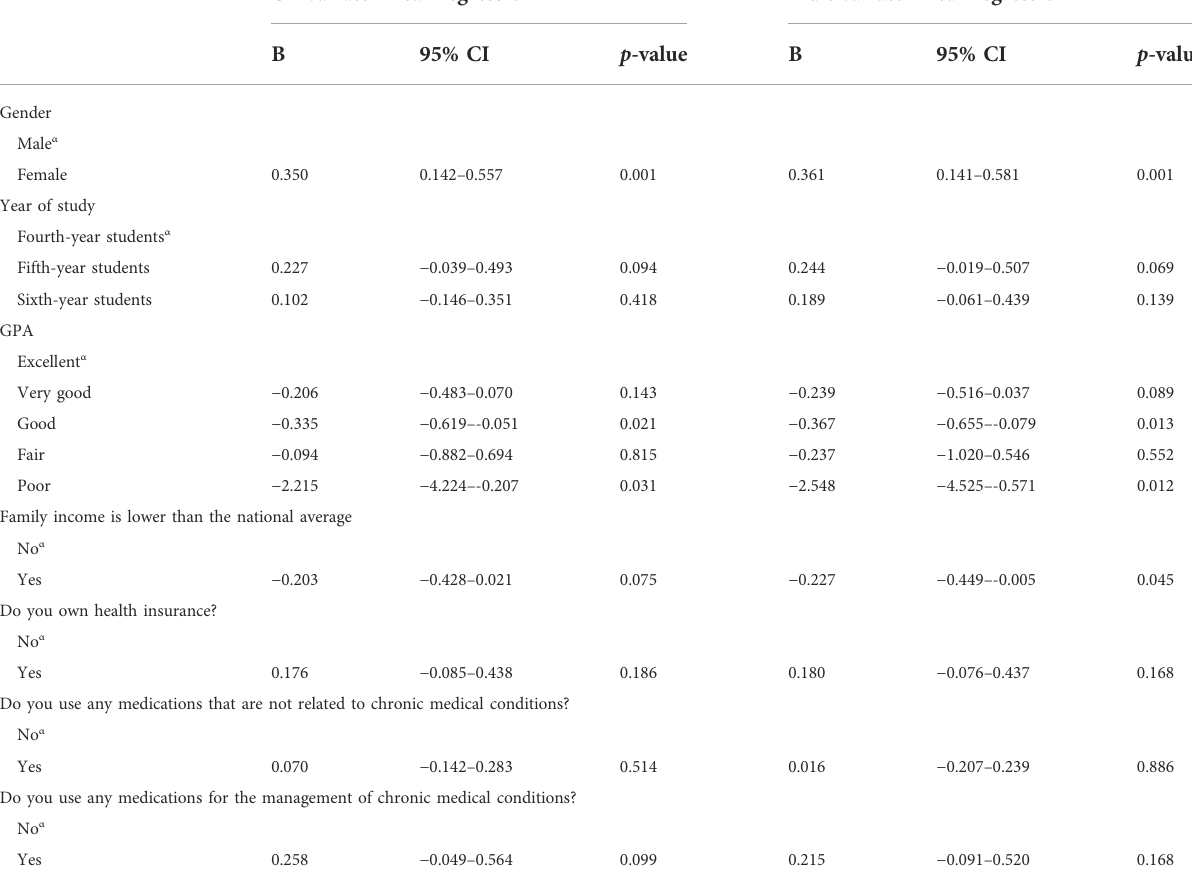
TABLE 4 Predictors of knowledge score among medical students, N =